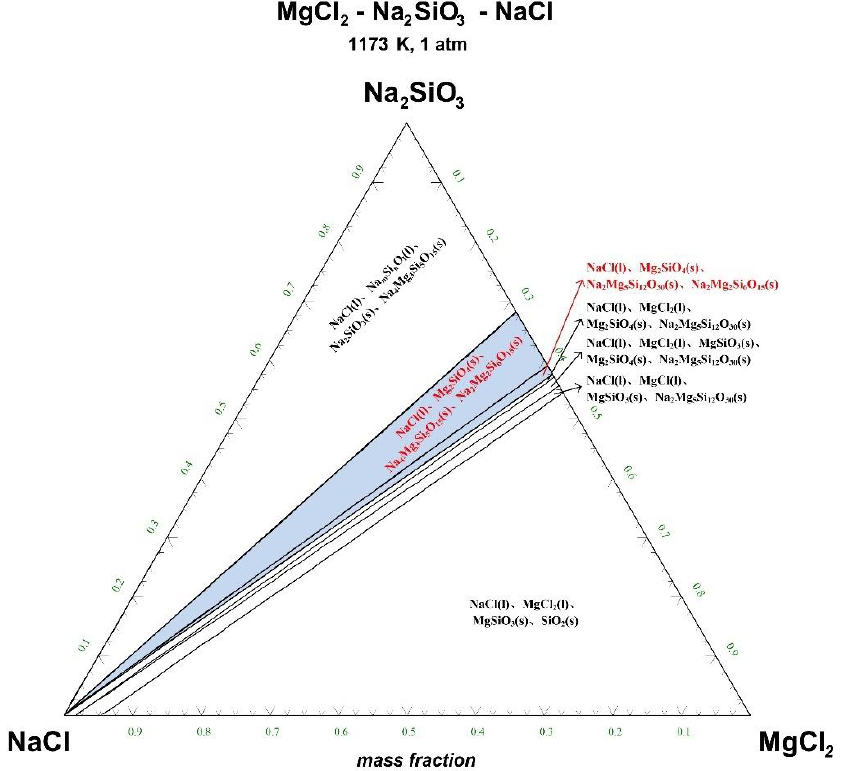
Figure 5. Ternary phase diagram of MgCl 2 -Na 2 SiO 3 -NaCl system at 1173 K. (l — liquid; s — solid).